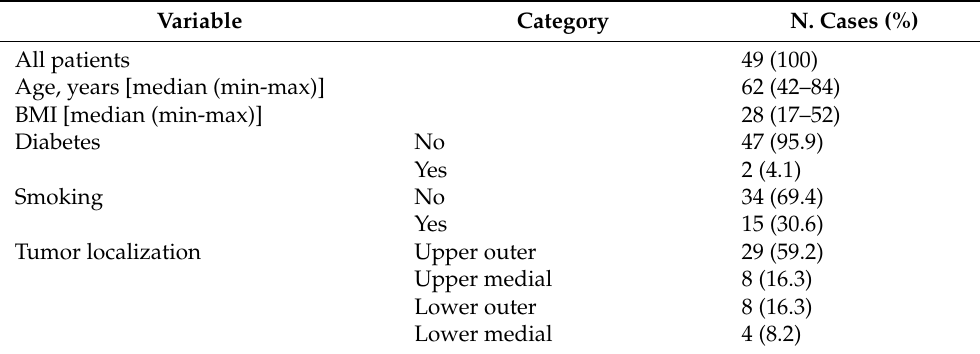
Table 1. Clinicopathological characteristic of 49 enrolled patients.